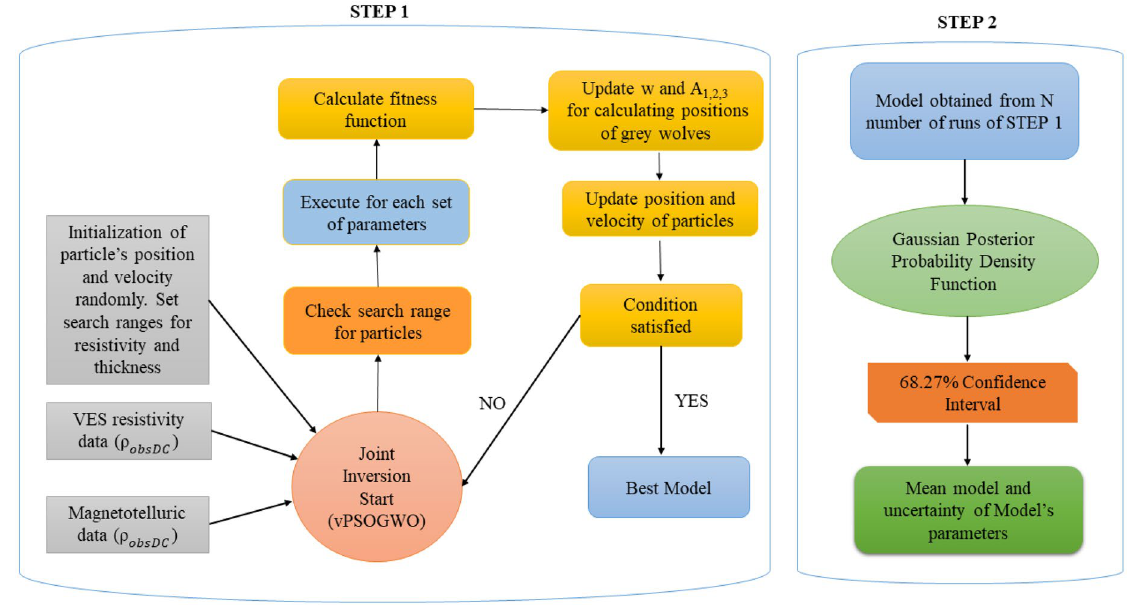
Figure 3. The procedures for individual and joint inversion of DC and MT data-based vPSOGWO are illustrated in a schematic flow